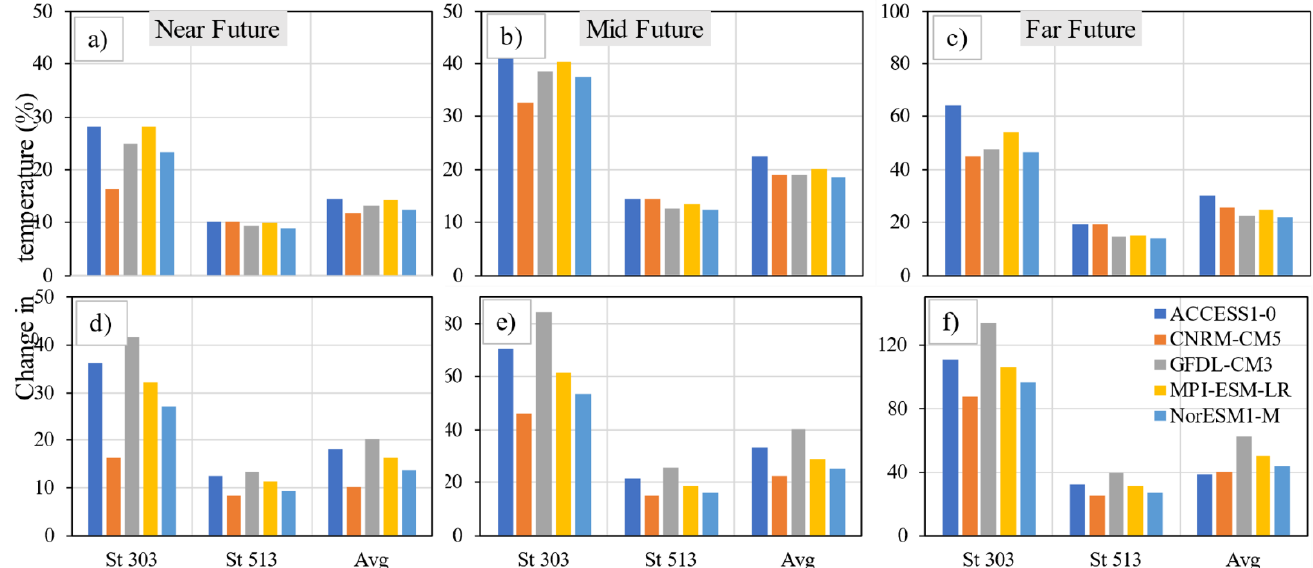
Figure 9. Changes in the minimum temperature for three future time windows, namely, Near Future (2021–2040), Mid Future (2041–2070), and Far Future (2071–2100) using multiple climate models under RCP 4.5 ( a – c ) and RCP 8.5 ( d – f ). ( a – c ) show the percentage change in temperature under the RCP 4.5 emission scenario. ( d – f ) show the same under the RCP 8.5 emission scenario. Additionally, ( a , d ) show the same for the Near Future, ( b , e ) for the Mid Future, and ( c , f ) for the Far Future.